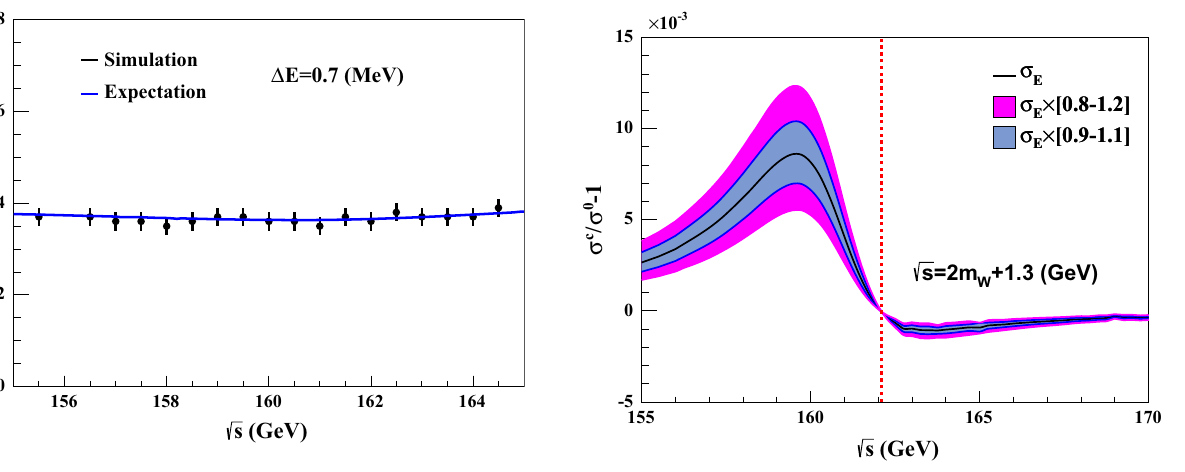
Fig. 6 (The dependence of Δ m W on the energy with a the Δ E = 0 . 7 MeV. The black dots with error bars are the simulations results and the blue curve is the numerical result of Eq. 9